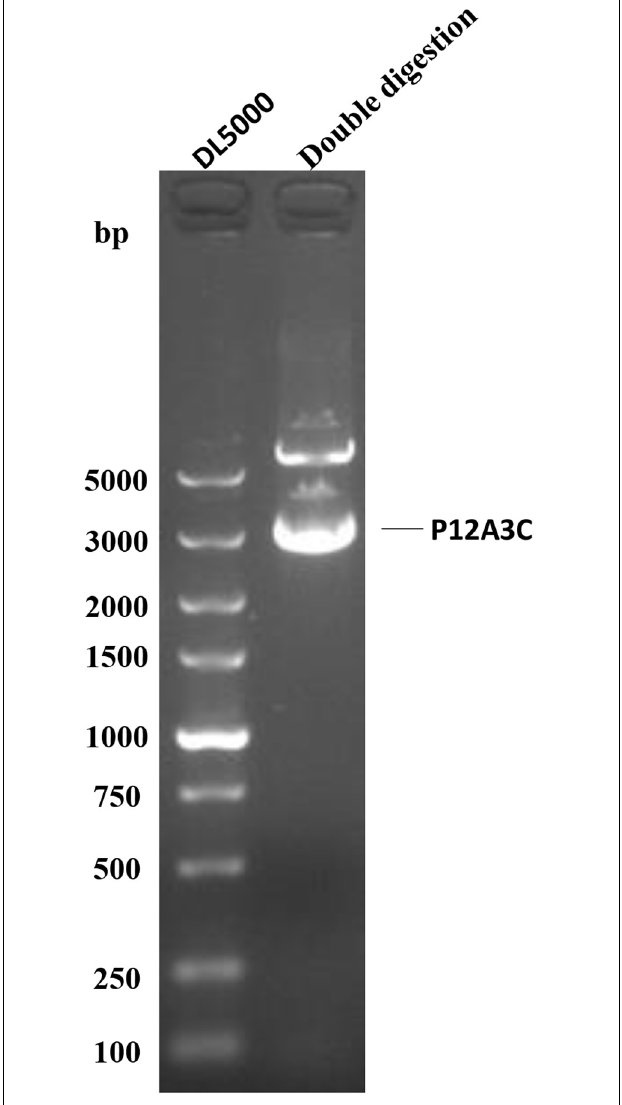
FIGURE 1 | Identification of the shuttle vector with double enzymatic